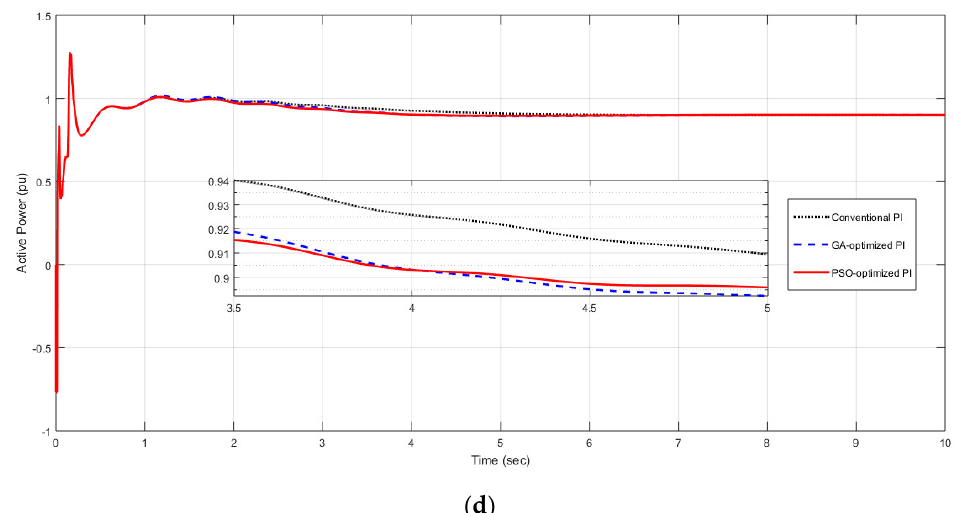
Figure 6. System response in Case 1: ( a ) pitch angle in degrees; ( b ) change in generator speed; ( c ) change in active power; ( d ) output power.